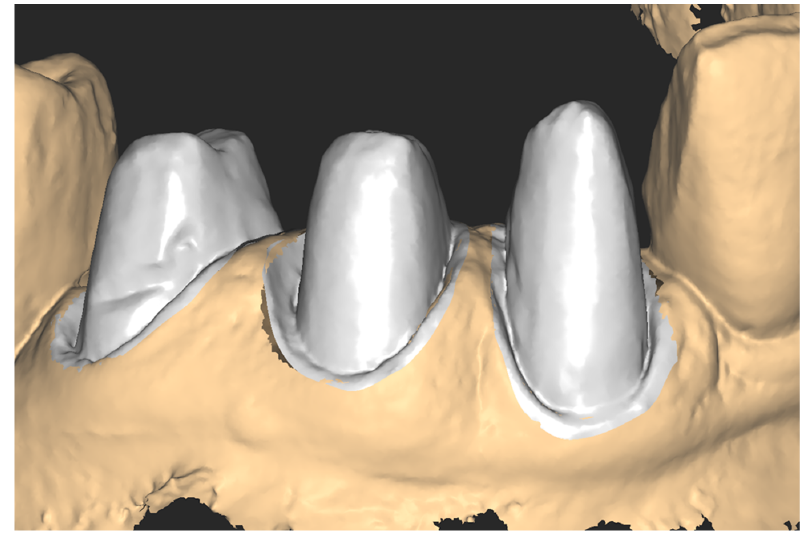
Figure 15. Substitution of the digital abutments on the master model.